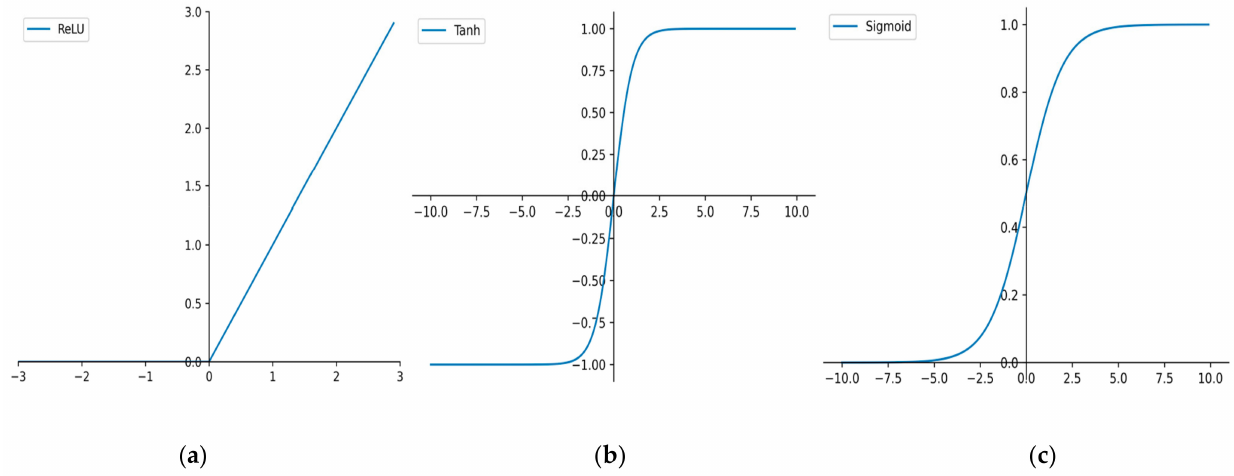
Figure 3. Three kinds of activation